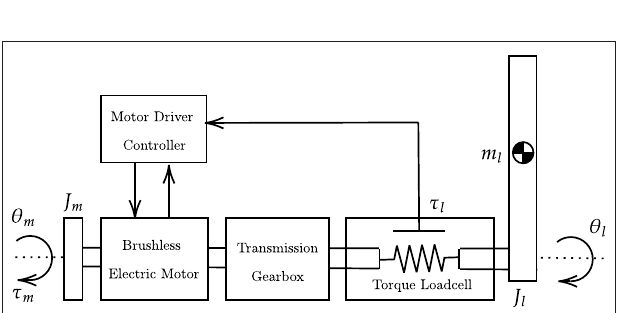
FIGURE 2 | Actuation chain model. The actuation chain consists of an electric motor provided with an angular encoder, a transmission gearbox, a torsional torque sensor and an aluminum bar load. The motor driver acquires input signals from the actuation chain and commands torque set-points to the electric